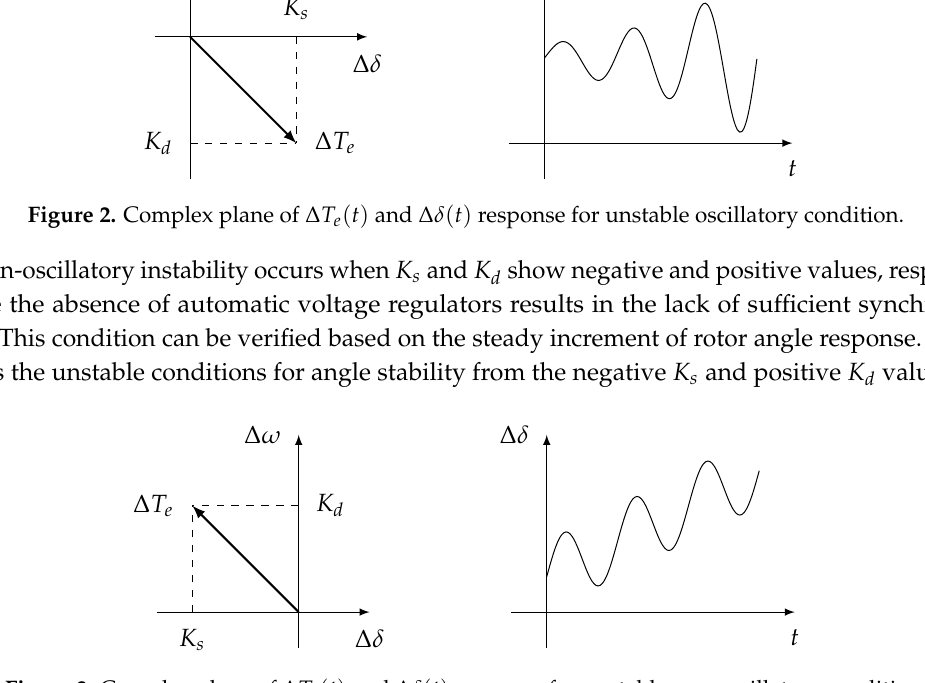
Figure 3. Complex plane of ∆ T e ( t ) and ∆ δ ( t ) response for unstable non-oscillatory